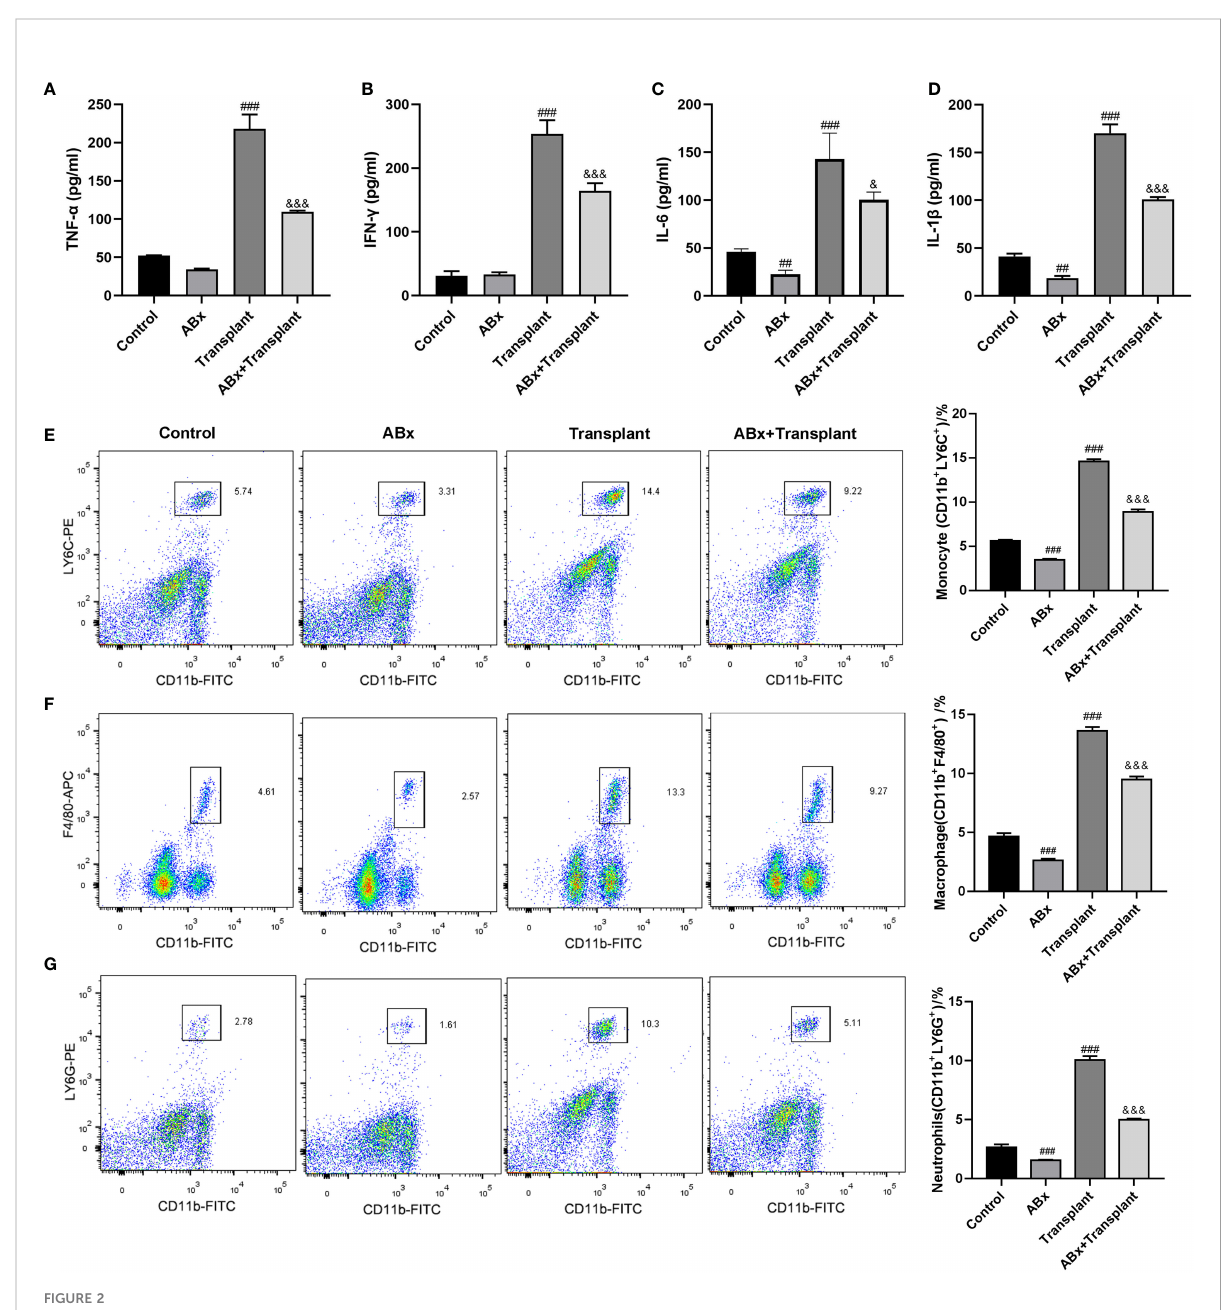
FIGURE 2 Effect of intestinal fl ora imbalance on in fl ammatory response in renal transplantation mice. (A-D) ELISA was used to detect the expression levels of TNF- a 、 IFN- g 、 IL-6 and IL-1 b in renal tissue. (E-G) Flow cytometry used to detect the in fi ltration of in fl ammatory cells (monocytes, macrophages, neutrophils) in the renal tissue. ## p < 0.01, ### p < 0.001 vs Control group; & p < 0.05, &&& p < 0.001 vs transplant